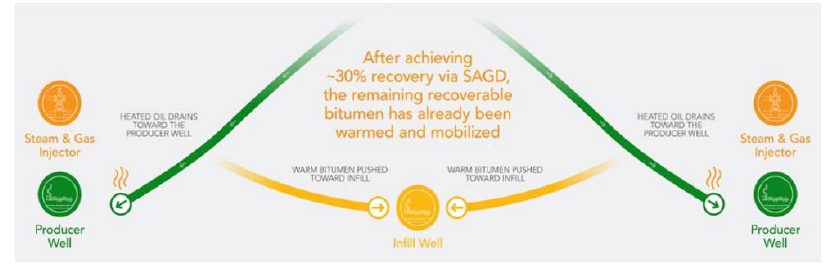
Figure 2. Schematic diagram of EMVAPEX [23].